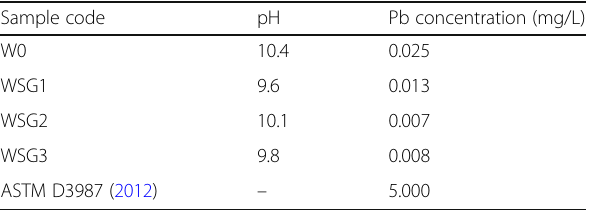
Table 6 Leachability of Pb ratio in the samples sintered at 900 °C/2 h Sample code